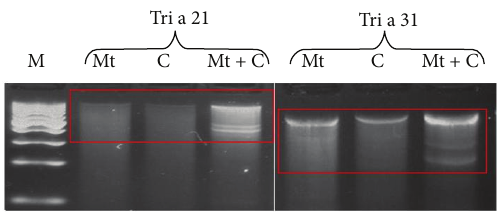
Figure 1: Electrophoretic pattern on a 3% acrylamide gels of Tri a 21 M1 and Tri a 31 M1 allergen fragments amplified in the two different genotypes and digested with Surveyor nuclease for SNPs detection. (M: Marker 100bp; Mt: mutant; C: control (referred to Svevo cv.); Mt + C: heteroduplex from both mutant and control.)